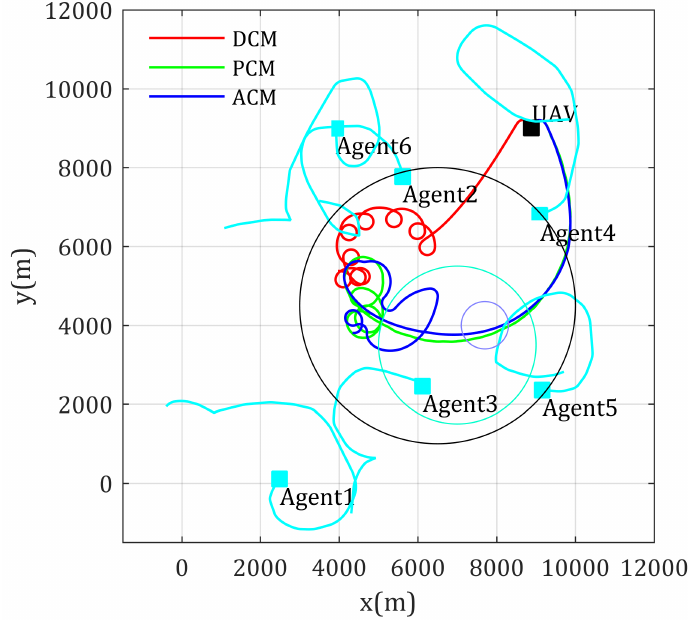
Figure 12. Paths for multi-mobile-agents-inter communication with known channel